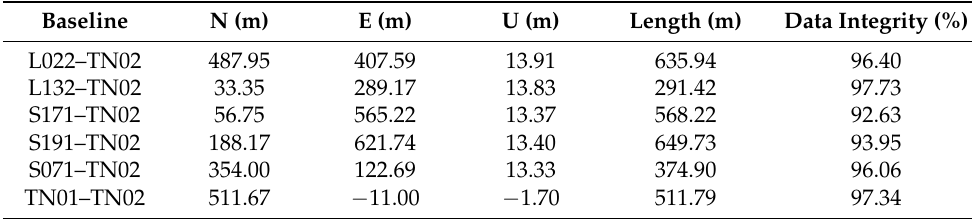
Table 1. Baseline information for the GPS network.